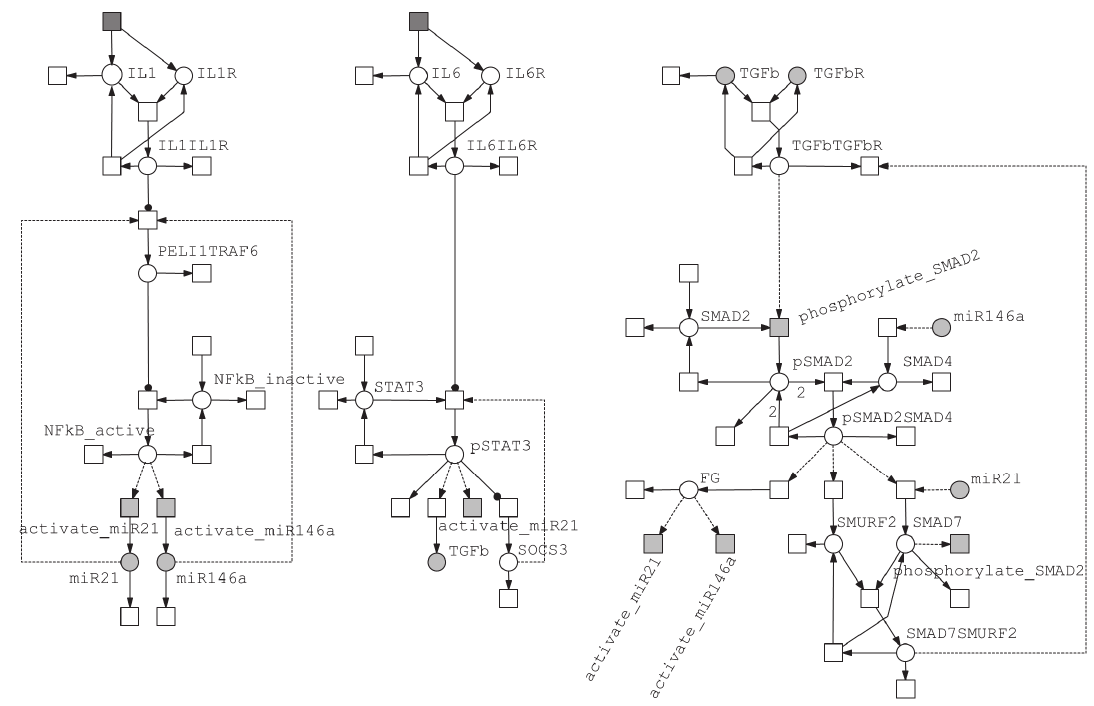
Figure 3. Graphical representation of the Petri net model. Light gray nodes represent “logical” elements that allow for crosstalk; dark gray nodes represent input stimuli. Edges with arrows correspond to mass flux. Edges with round ends (“read edges”) correspond to influences without affecting the levels of the source nodes. Dashed edges (“modifier edges”) correspond to inhibitory